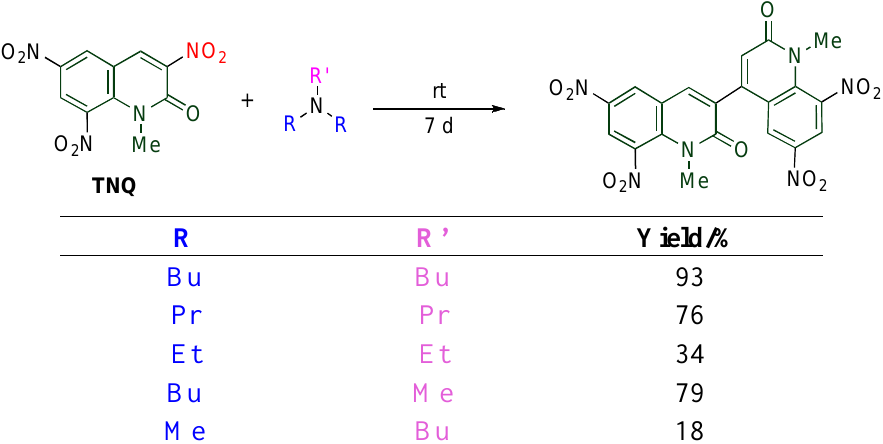
Table 7. Dimerization of TNQ depending on amine